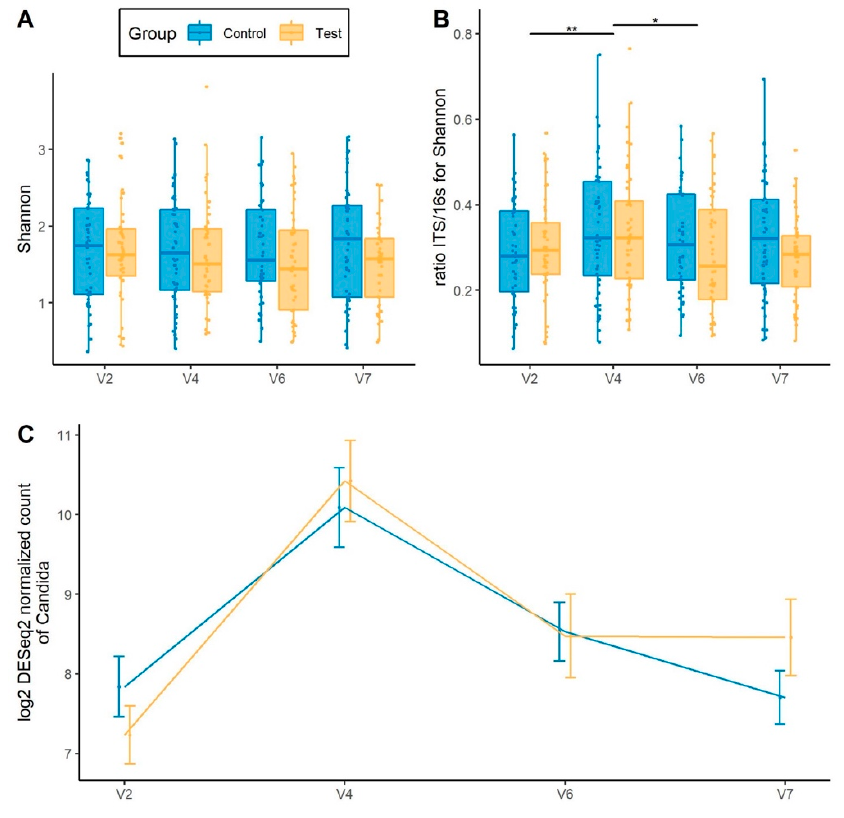
Figure 4. Global gut mycobiota response to Hp treatment and product intervention. ( A ) Alpha-diversity assessed by Shannon index ( B ) Shannon index ratio ITS/16S based ( C ) Abundance of Candida . * p < 0.05 and ** p < 0.01 according to Mann–Whitney test.